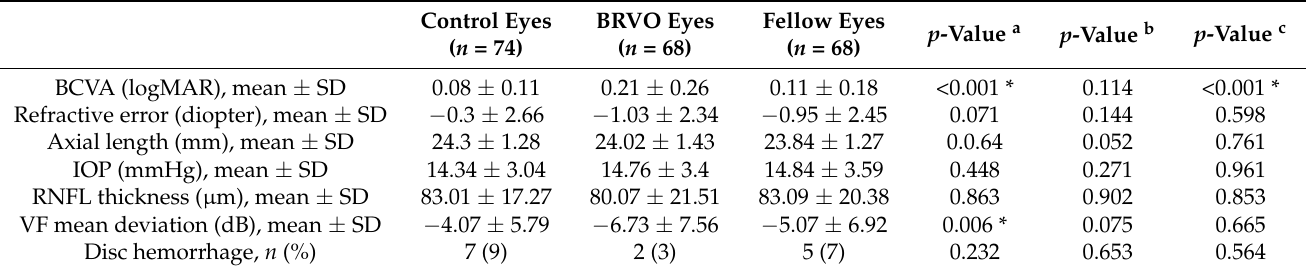
Table 2. Ocular parameters of the groups.